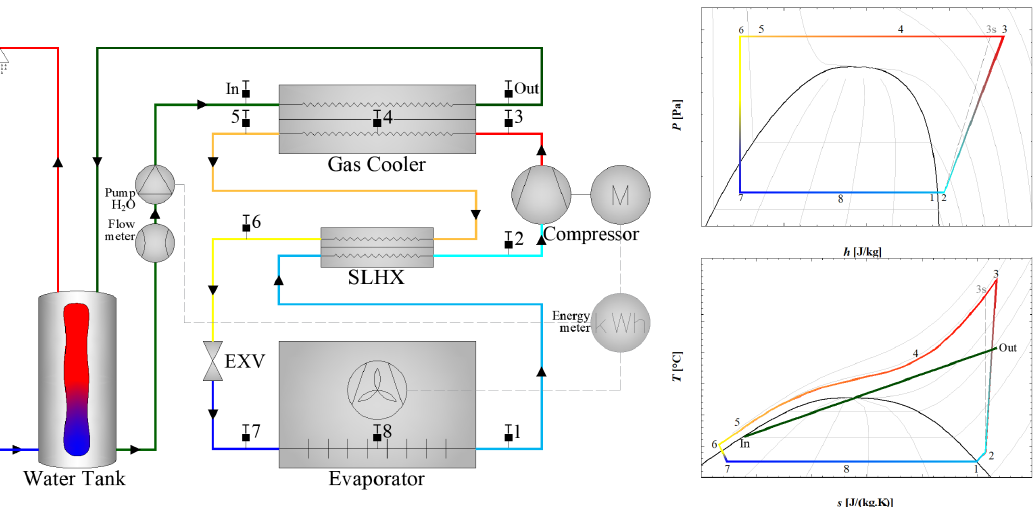
Figure 1. TCO 2 HPWH: scheme ( left ), and 𝑃 − ℎ ( top left ) and 𝑇 − 𝑠 ( bottom right ) diagrams.